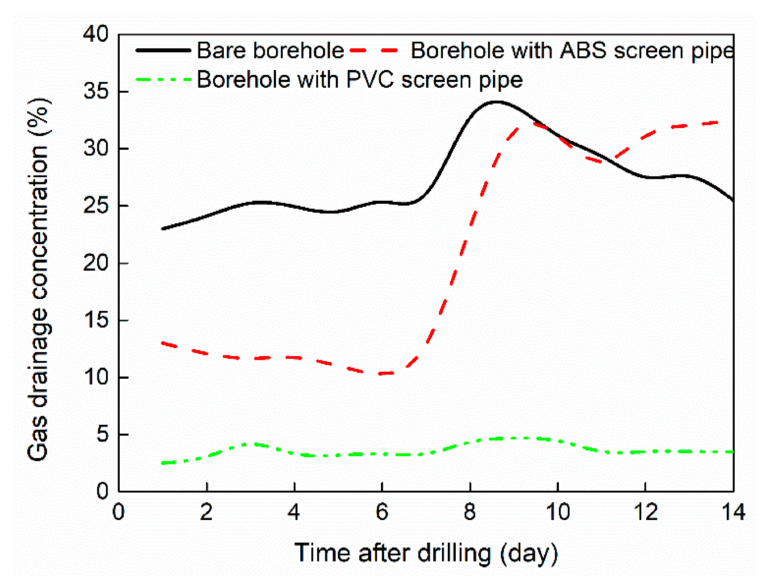
Figure 11. Variation in gas drainage concentration under different borehole protection